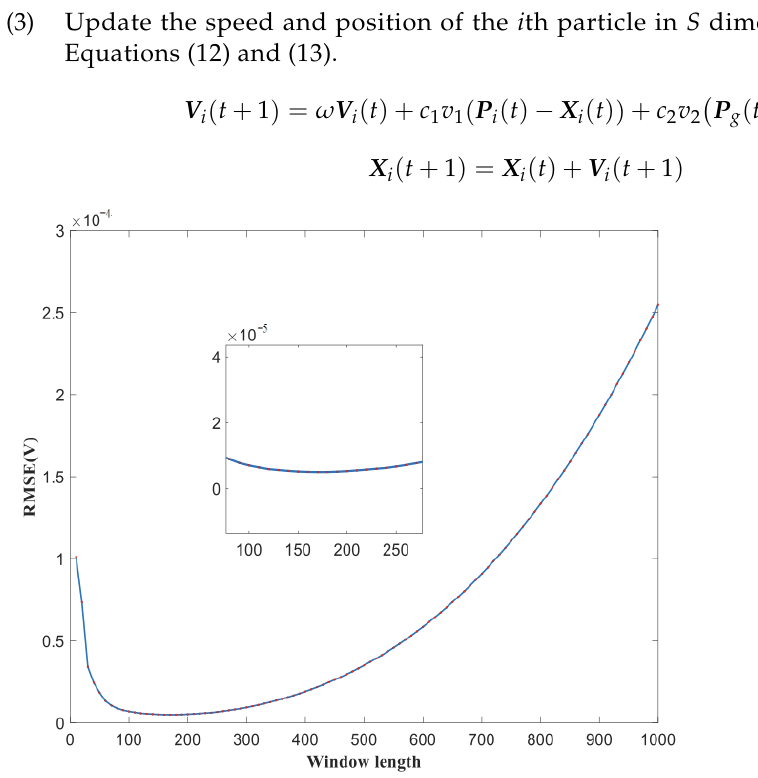
Figure 3. The influence of different window lengths for signal separation.